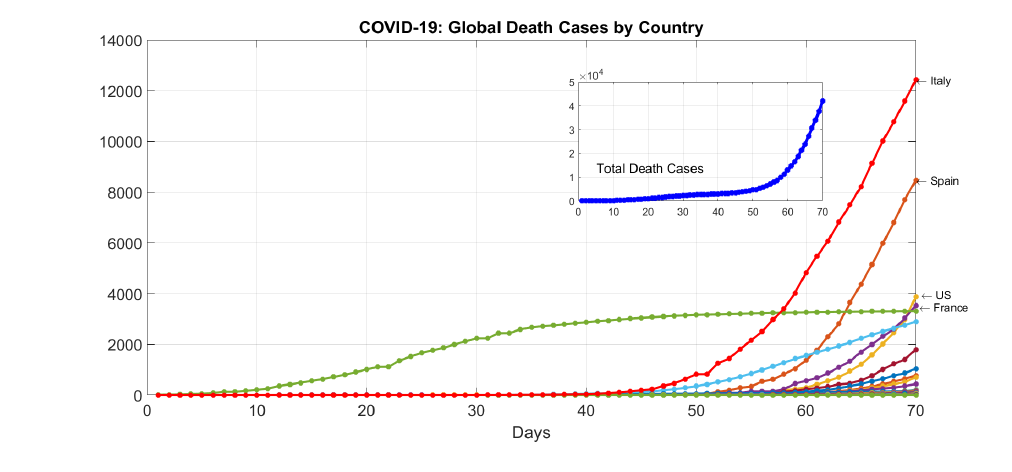
Figure 7. Time series of global death cases of COVID-19 from 22 January to 31